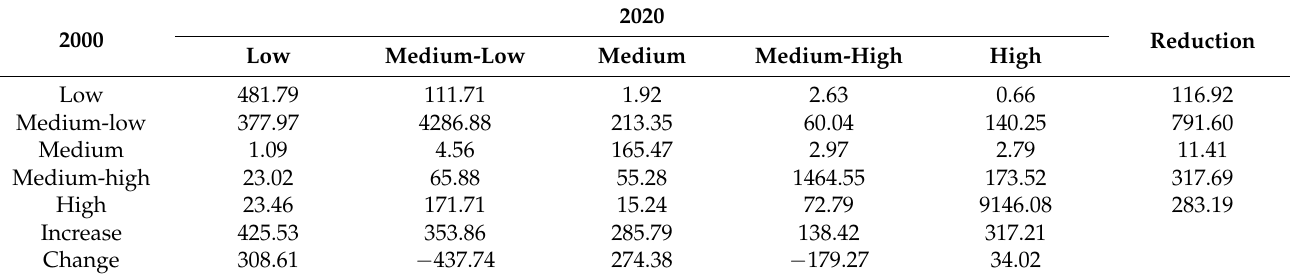
Table 6. Spatial transfer matrix of habitat quality in the study area (unit: km 2 ).